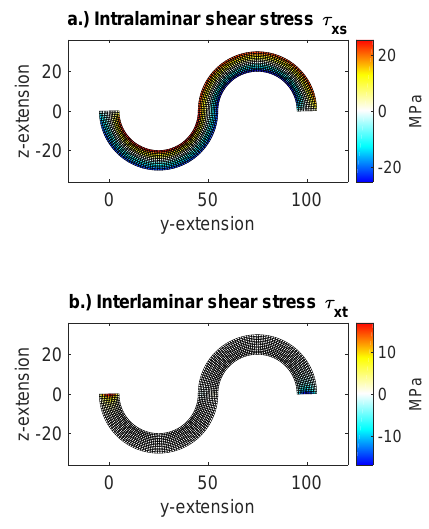
Figure 26: Shear stress distribution in a CFRP [0 4 ] semi-circularly corrugated laminate subjected to torsional loading. For better visibility, the laminate thickness was increased to t = 10 mm . The results for the finite-width plates were produced using the code presented in [62] with deactivated periodicity boundary condition.